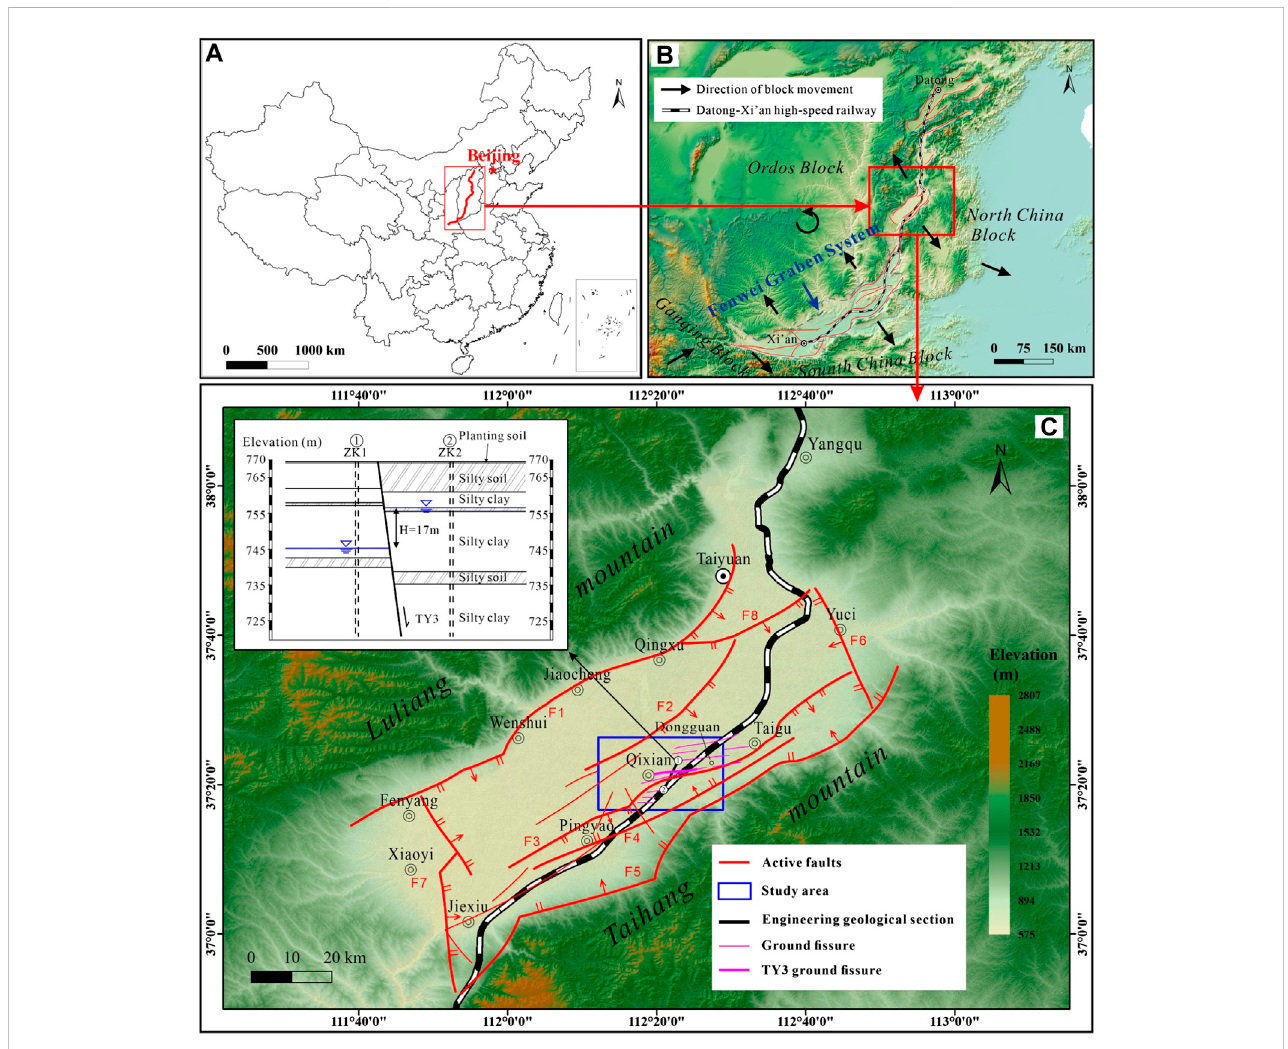
FIGURE 1 Relationshipbetweenhigh-speedrailwayandground fi ssures. (A) DatongtoXi ’ anPassengerDedicatedLine(DXPDL)inChina; (B) Fenweibasin; (C) Study areainTaiyuanbasin(F1: Jiaochengfault;F2:Longjiayingfault;F3:Qixianfault;F4: Pingyao-Taigu fault;F5:Hongshan-Fancunfault;F6:Yuci-Beitian fault;F7: Sanquan fault; F8: Tianzhuang